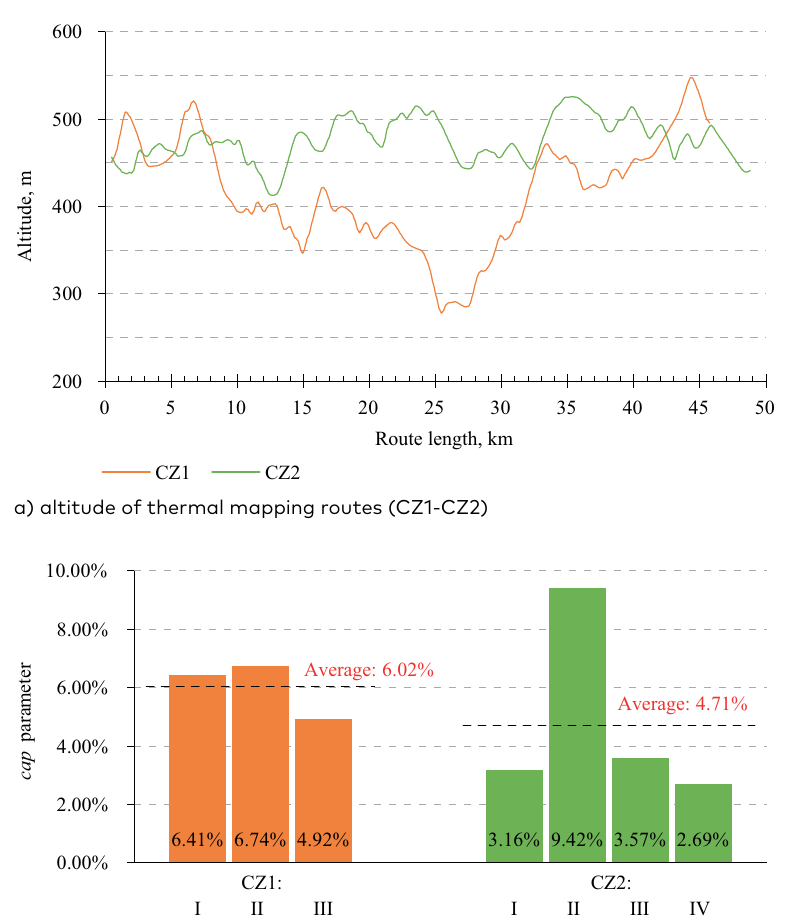
Figure 2. Comparison of altitude and cap parameter in the Czech